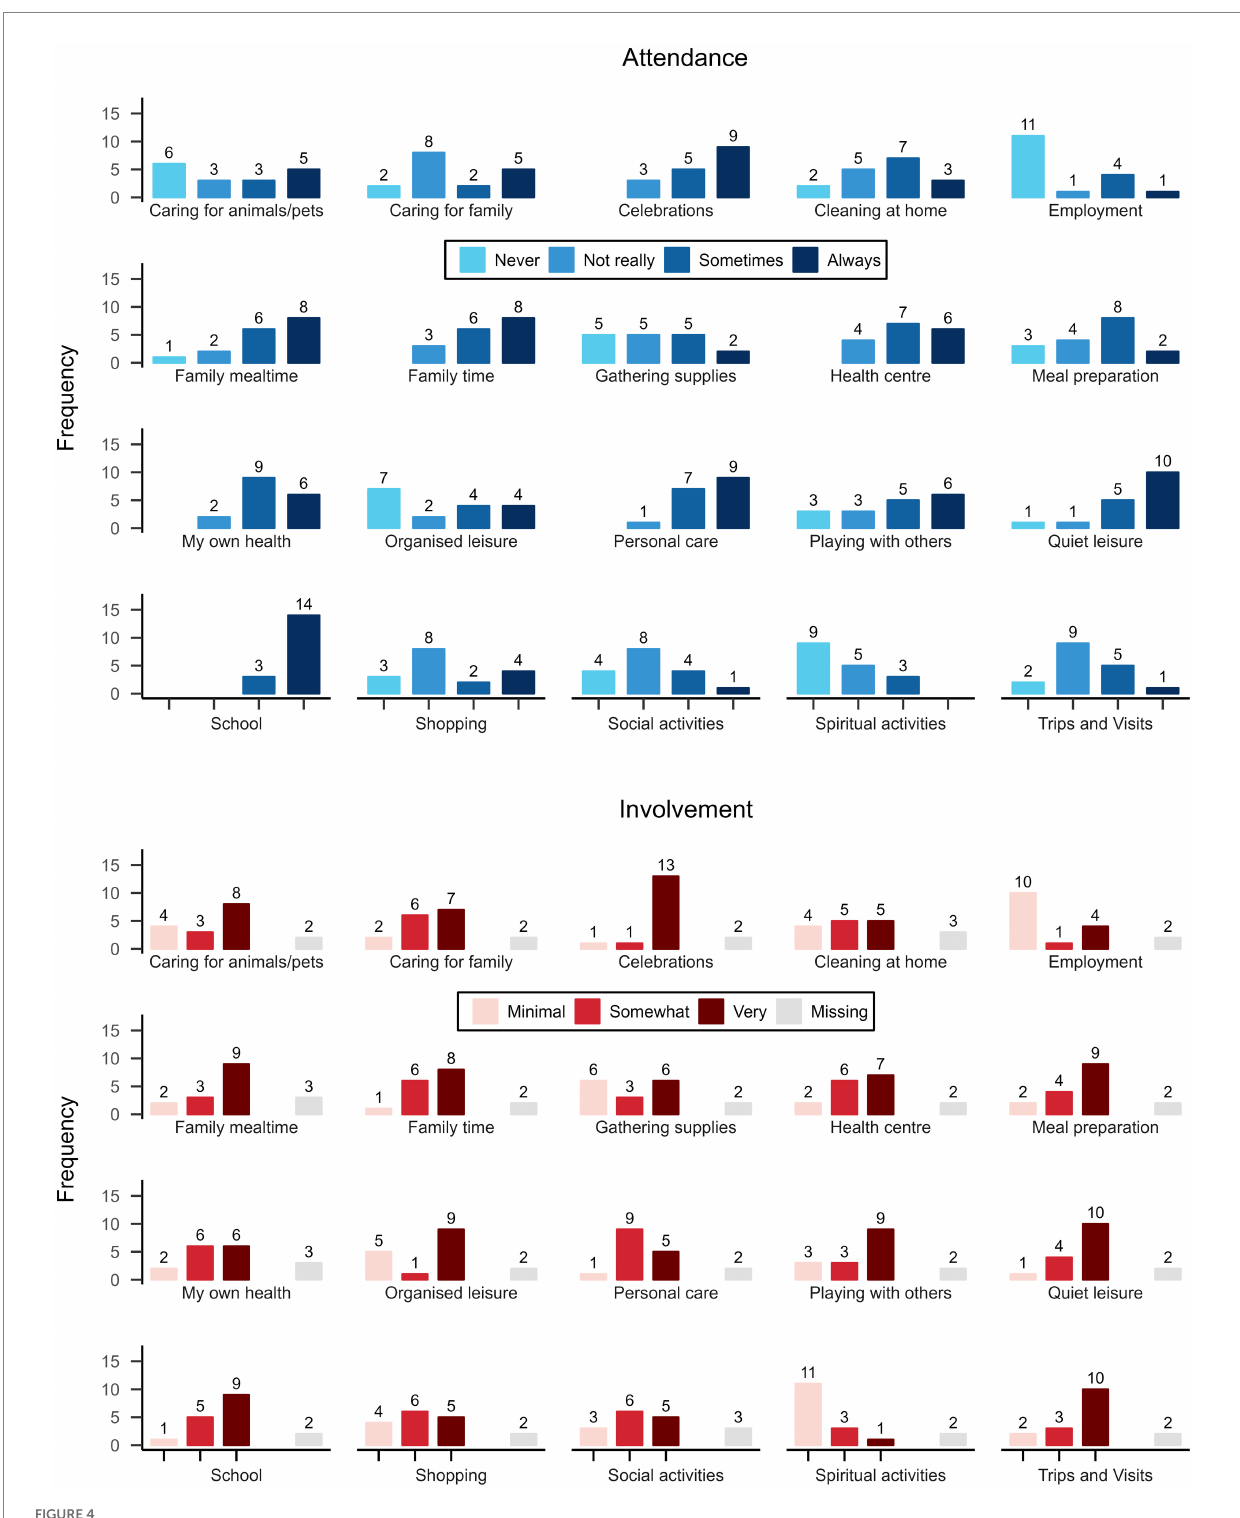
FIGURE 4 Picture my participation: attendance and involvement in